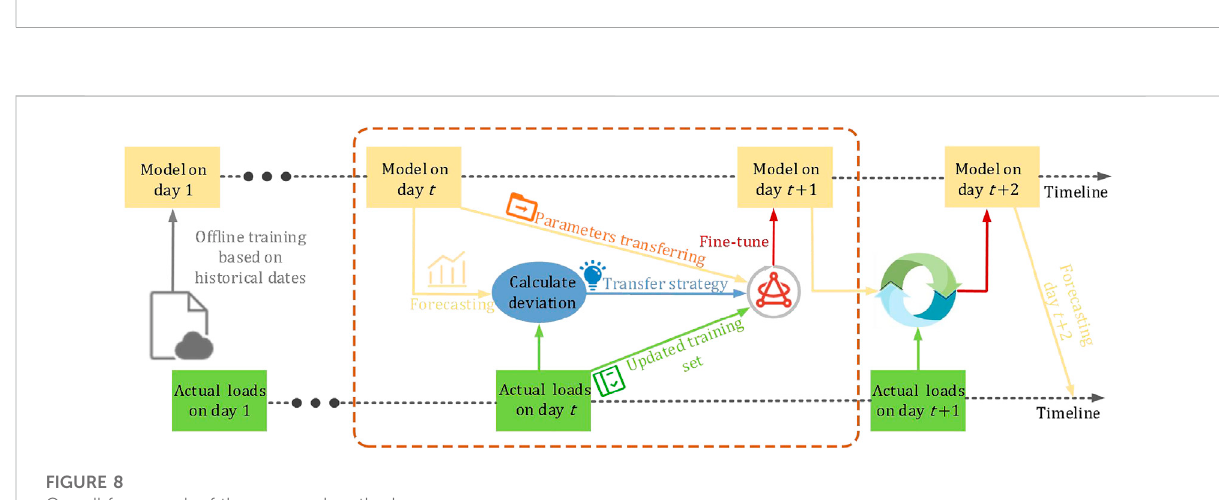
FIGURE 7 Strategies of the transfer learning.